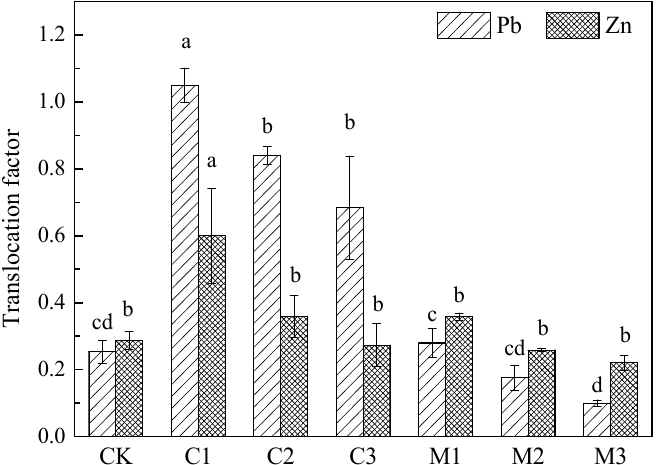
Figure 6. Translocation factor of Nerium indicum under calcium carbonate and mushroom residue improved treatment.